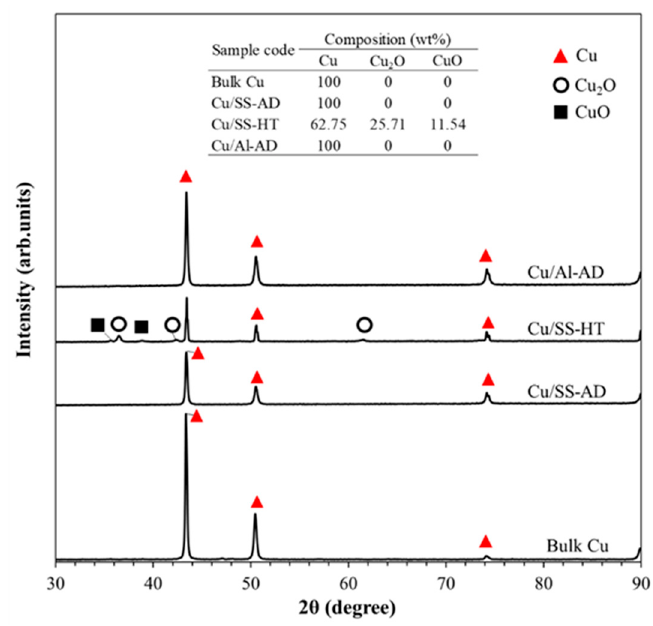
Figure 7. XRD spectra of bulk Cu, Cu/SS ‐ AD, Cu/SS ‐ HT, and Cu/Al ‐ AD samples.